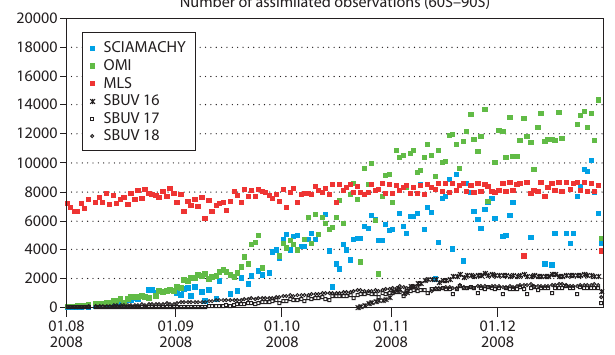
Fig. 1. Number of assimilated satellite observations per day over Antarctica (60 ◦ S–90 ◦ S) in the period from 1 August to 31 Decem- ber